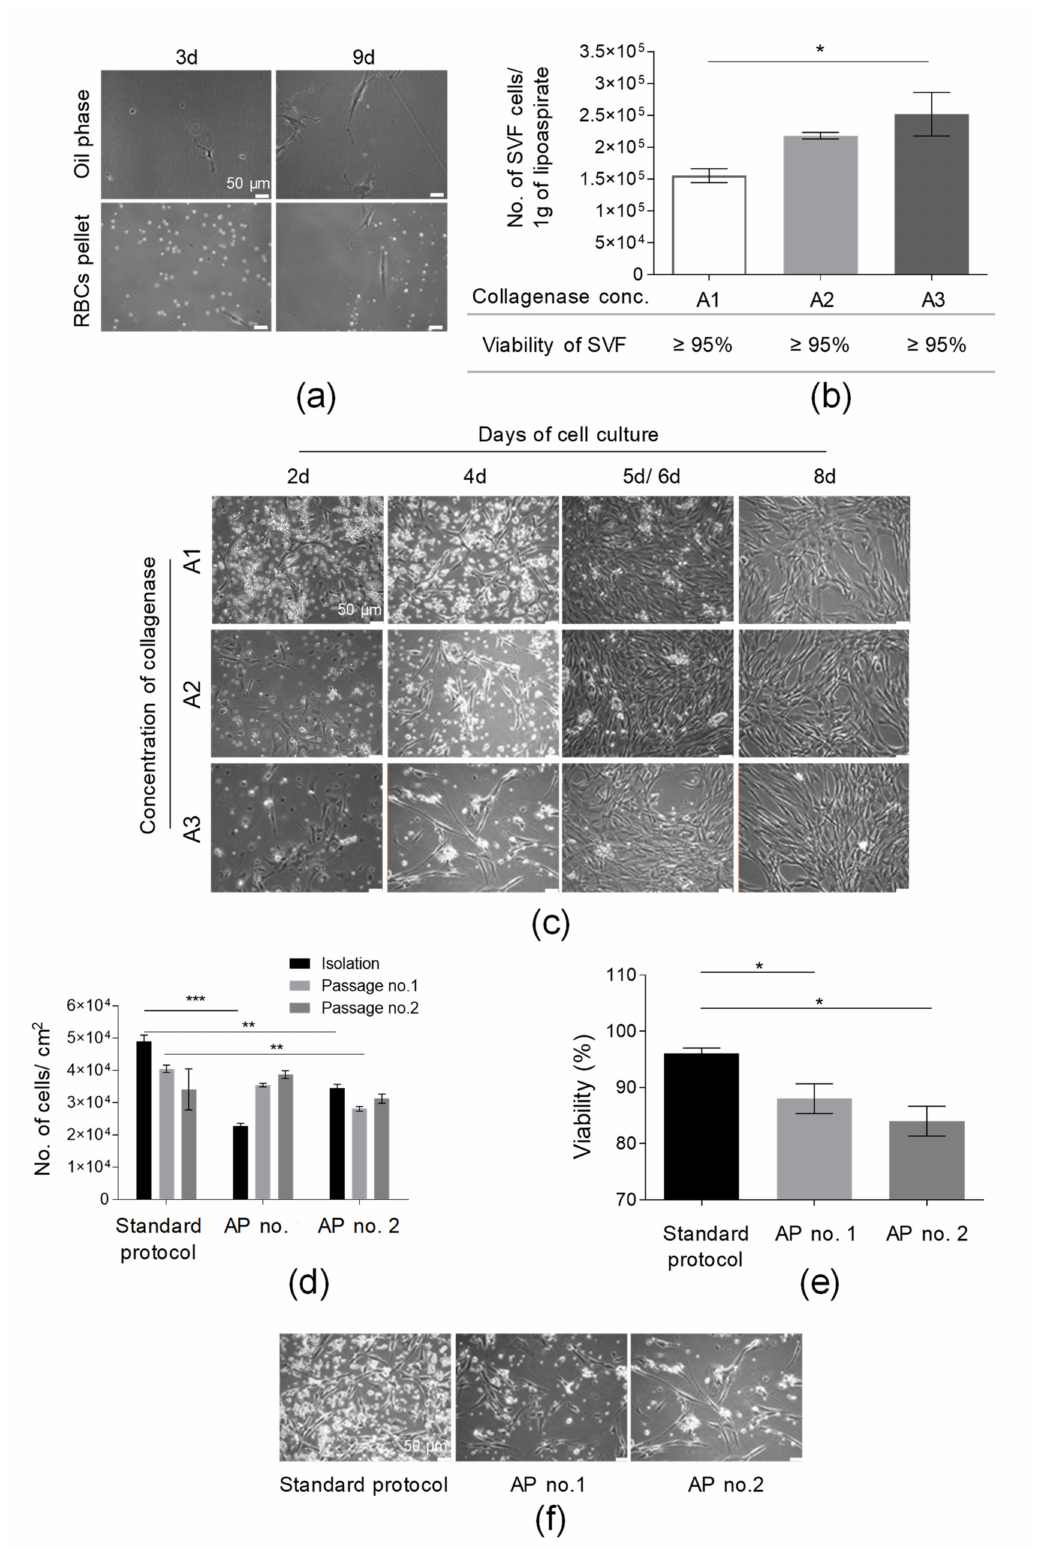
Figure 2. Optimization of the procedure of isolation of SVF cells from adipose tissue (AT). ( a ) Washing of AT with PBS did not cause the loss of adherent cells of SFV. Representative images of a few cells isolated from PBS obtained after the washing of AT 3 and 9 days post-seeding. PBS were centrifuged (300 × g , 5 min, RT); the oil phase and, subsequently, pellet containing RBCs and tissue sections were resuspended in complete culture medium (DMEM/F12 supplemented with 10% FBS and 1% Penicillin-Streptomycin solution) and cultured for 9 days. ( b ) Examination of the suitability of selected